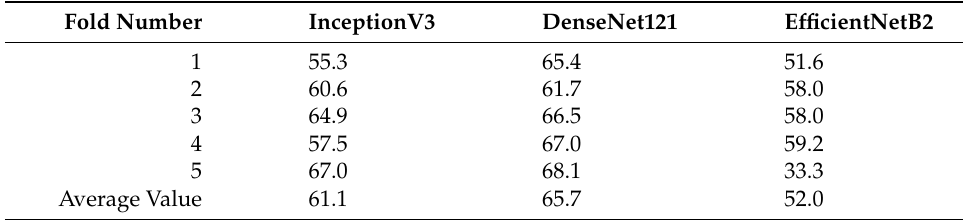
Table 14. Validation accuracy of single Chinese character multi-category classification.